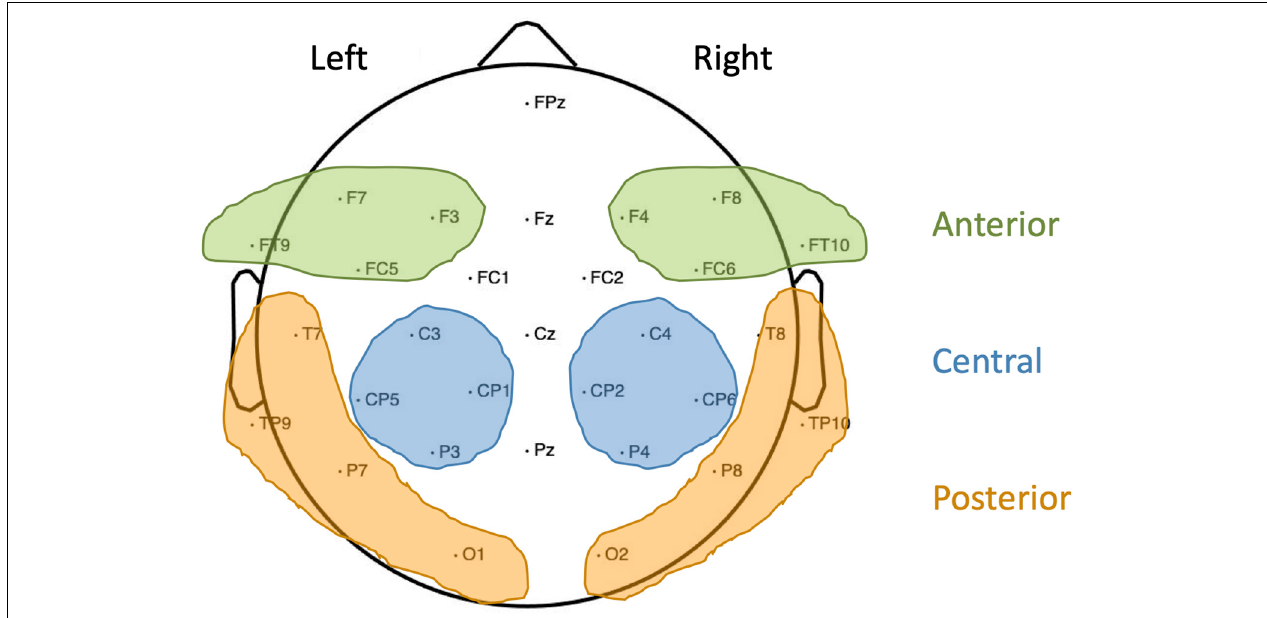
FIGURE 2 | Overview of electrodes used and regions of interest formed. For the P350, left and right anterior (shaded green) and posterior (shaded yellow) regions were used. For the N400, left and right central regions (shaded blue) were